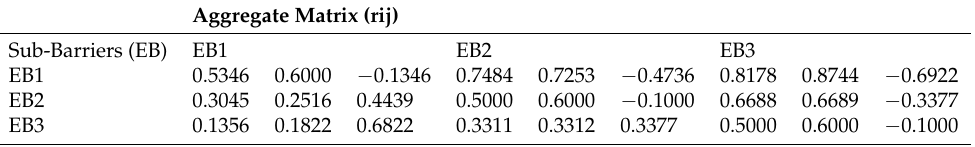
Table A2. The aggregated IF judgment matrix.